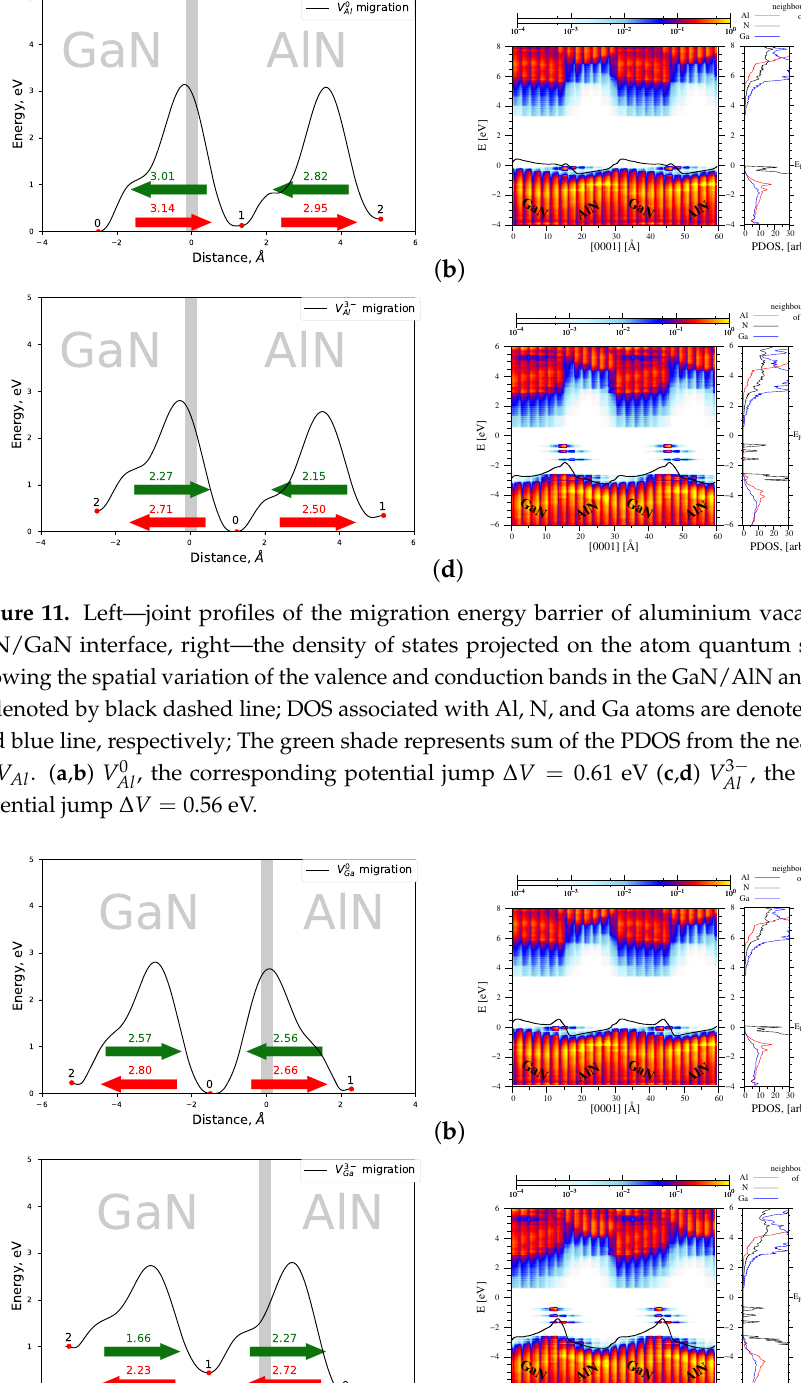
Figure 12. Left—joint profiles of the migration energy barrier of gallium vacancy V Ga at the AlN/GaN interface, right—the density of states projected on the atom quantum states (P-DOS), showing the spatial variation of the valence and conduction bands in the GaN/AlN and the total DOS is denoted by black dashed line; DOS associated with Al, N, and Ga atoms are denoted by red, black, and blue line, respectively; The green shade represents sum of the PDOS from the nearest neighbors of V Ga . ( a , b ) V 0 , the corresponding potential jump ∆ V = 0.85 eV ( c , d ) V 3 − Ga jump ∆ V = 1.32